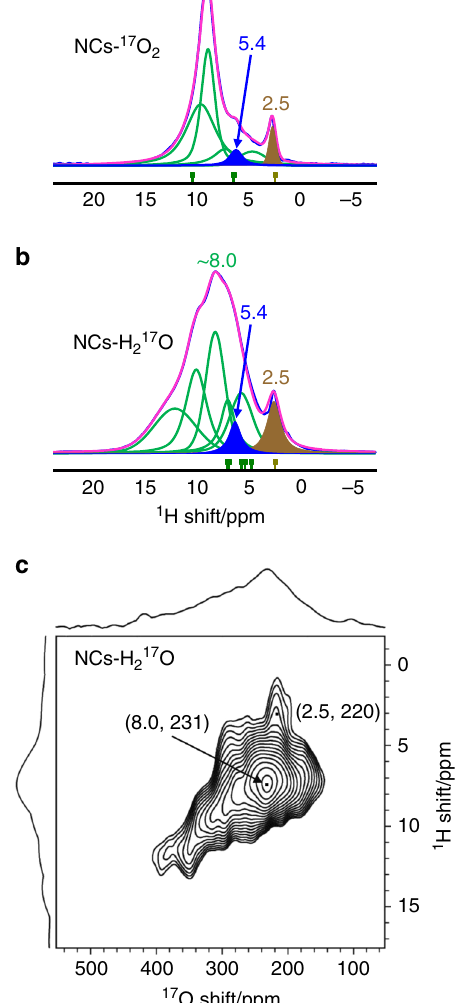
Fig. 2 1 H Solid-State NMR spectra and 1 H → 17 O HETCOR NMR of ceria nanocubes. The 1 H NMR measurements for NCs- 17 O 2 ( a ) and NCs-H 2 17 O ( b ) were performed at a spinning speed of 12kHz using a rotor synchronized Hahn-echo pulse sequence ( π /2- τ - π - τ -acquisition) with a recycle delay of 2.0s. Deconvolution of 1 H spectra and the summarized 1 H chemical shifts (obtained from DFT calculations, see below) are also shown. Background signals from the cap, rotor and probe etc. are removed by subtracting the spectra of an empty rotor obtained at the same condition from the initial spectrum. c The 1 H → 17 O HETCOR spectrum of NCs-H 2 17 O, recorded at a MAS rate of 14kHz with a recycle delay of 2s and a contact time of